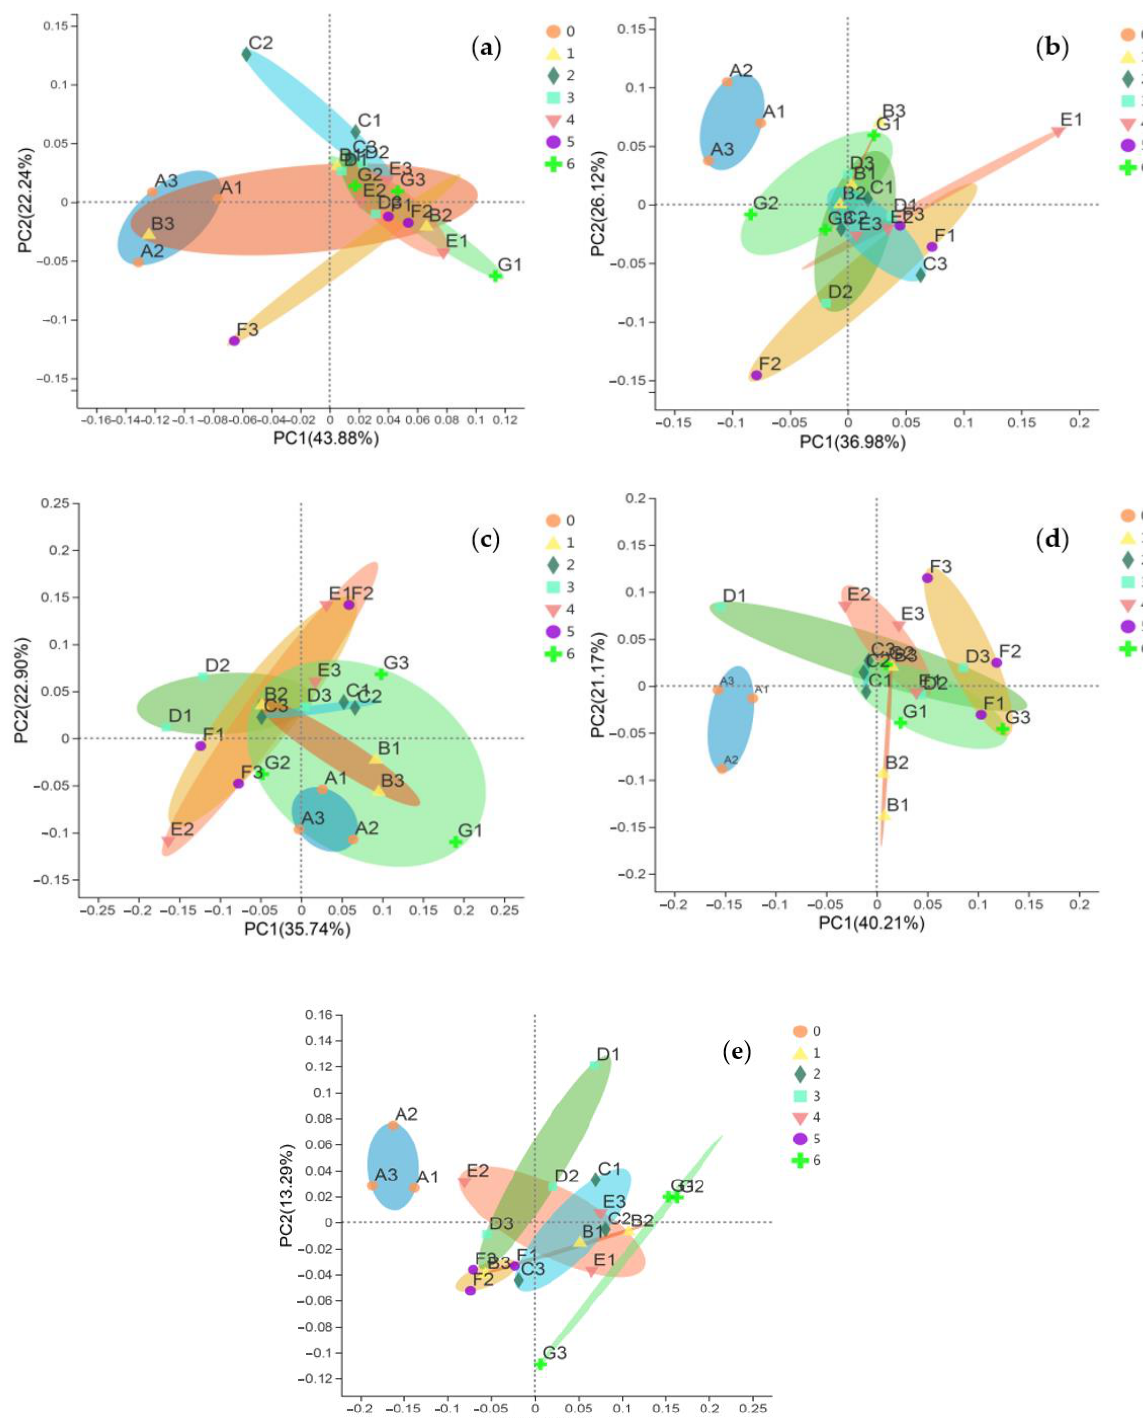
Figure 5. Principal co-ordinates analysis (PCoA) on the soil Cd forms of the organic treatments and the CK (0 mmol/kg); ( a ) oxalic acid (OA), ( b ) acetic acid (AA), ( c ) tartaric acid (TA), ( d ) malic acid (MA), and ( e ) citric acid (CA). A1, A2, and A3 are the three samples of CK (0 mmol/kg); B1, B2, and B3 are the three samples of 1 mmol/kg; C1, C2, and C3 are the three samples of 2 mmol/kg; D1, D2, and D3 are the three samples of 3 mmol/kg; E1, E2, and E3 are the three samples of 4 mmol/kg; F1, F2, and F3 are the three samples of 5 mmol/kg; G1, G2, and G3 are the three samples of 6